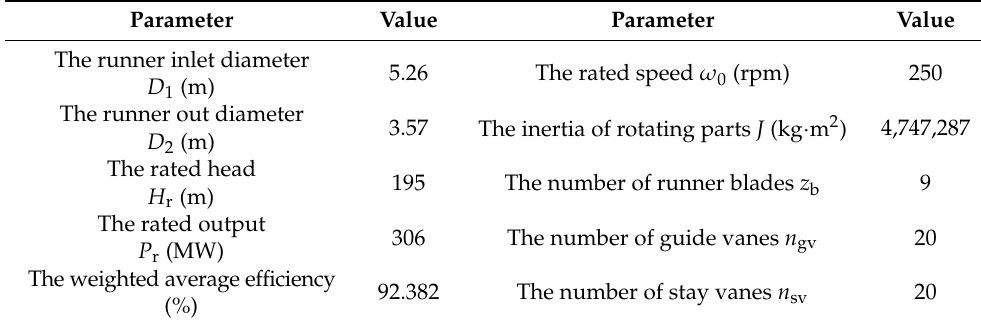
Figure 2. Schematic diagram of numerical computational domain. Table 1. Main parameters of the prototype pump-turbine.